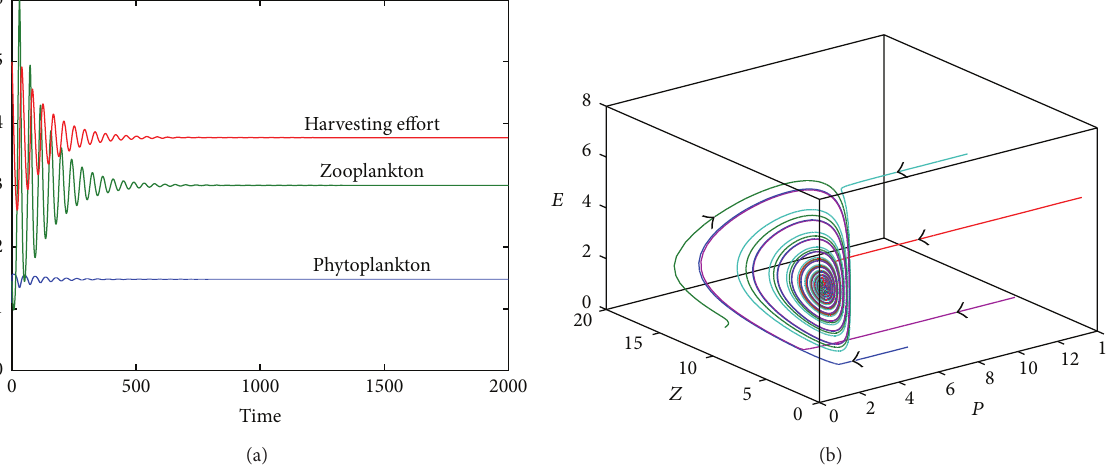
Figure 5: The globally asymptotical stability of positive equilibrium point. (a) Time series portrait. (b) The phase portrait with different initial values.